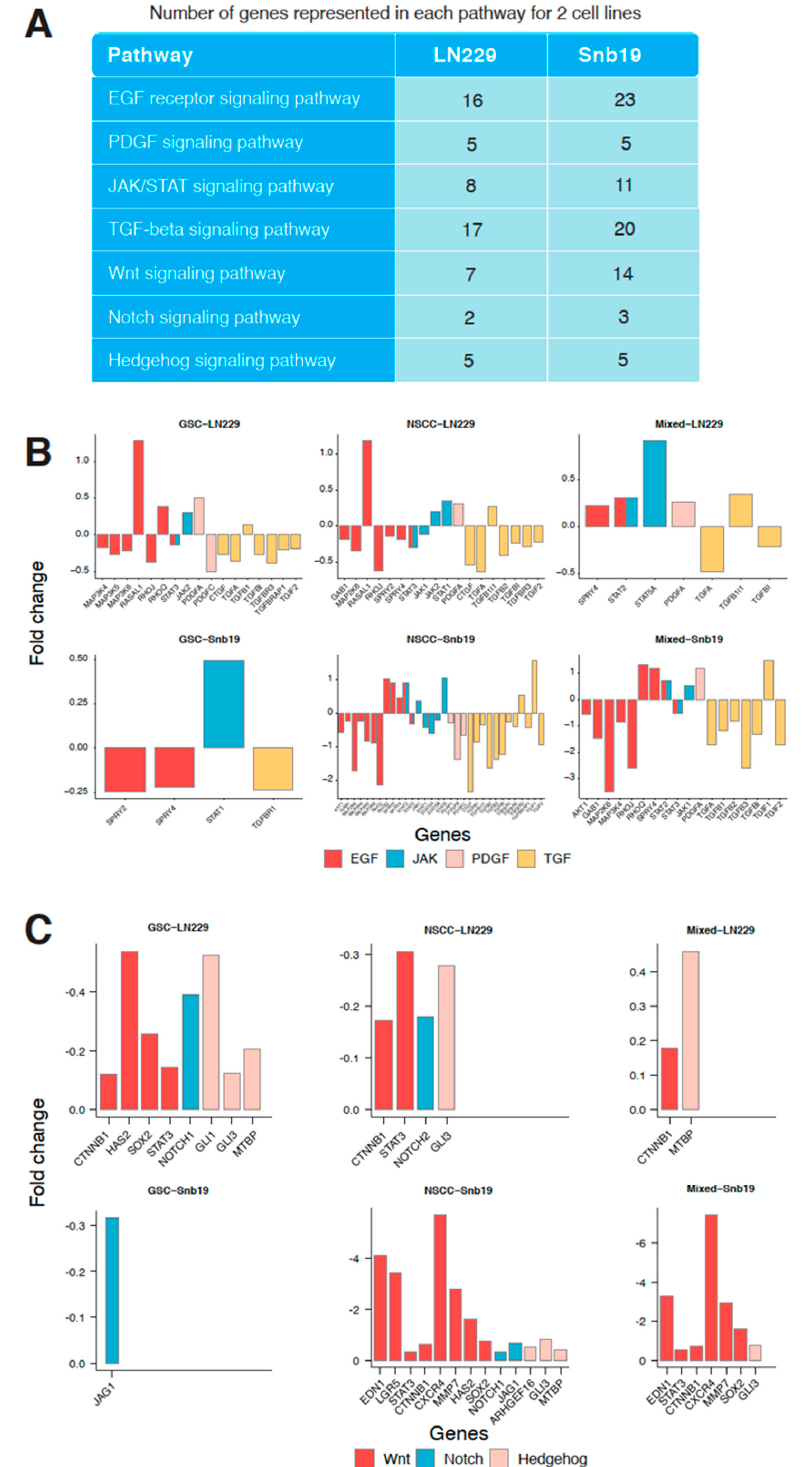
Figure 5. E ff ect of THTMP on multiple signaling pathways ( A ) Significant targeted signaling pathways upon THTMP treatment. ( B ) Comparison of DEGs fold change in EGF, PDGF, JAK / STAT, and TGF- β signaling pathways of GSC, NSCC and mixed populations. ( C ) Comparison of DEGs fold change in CSC signaling pathways in GSC, NSCC and progenitor